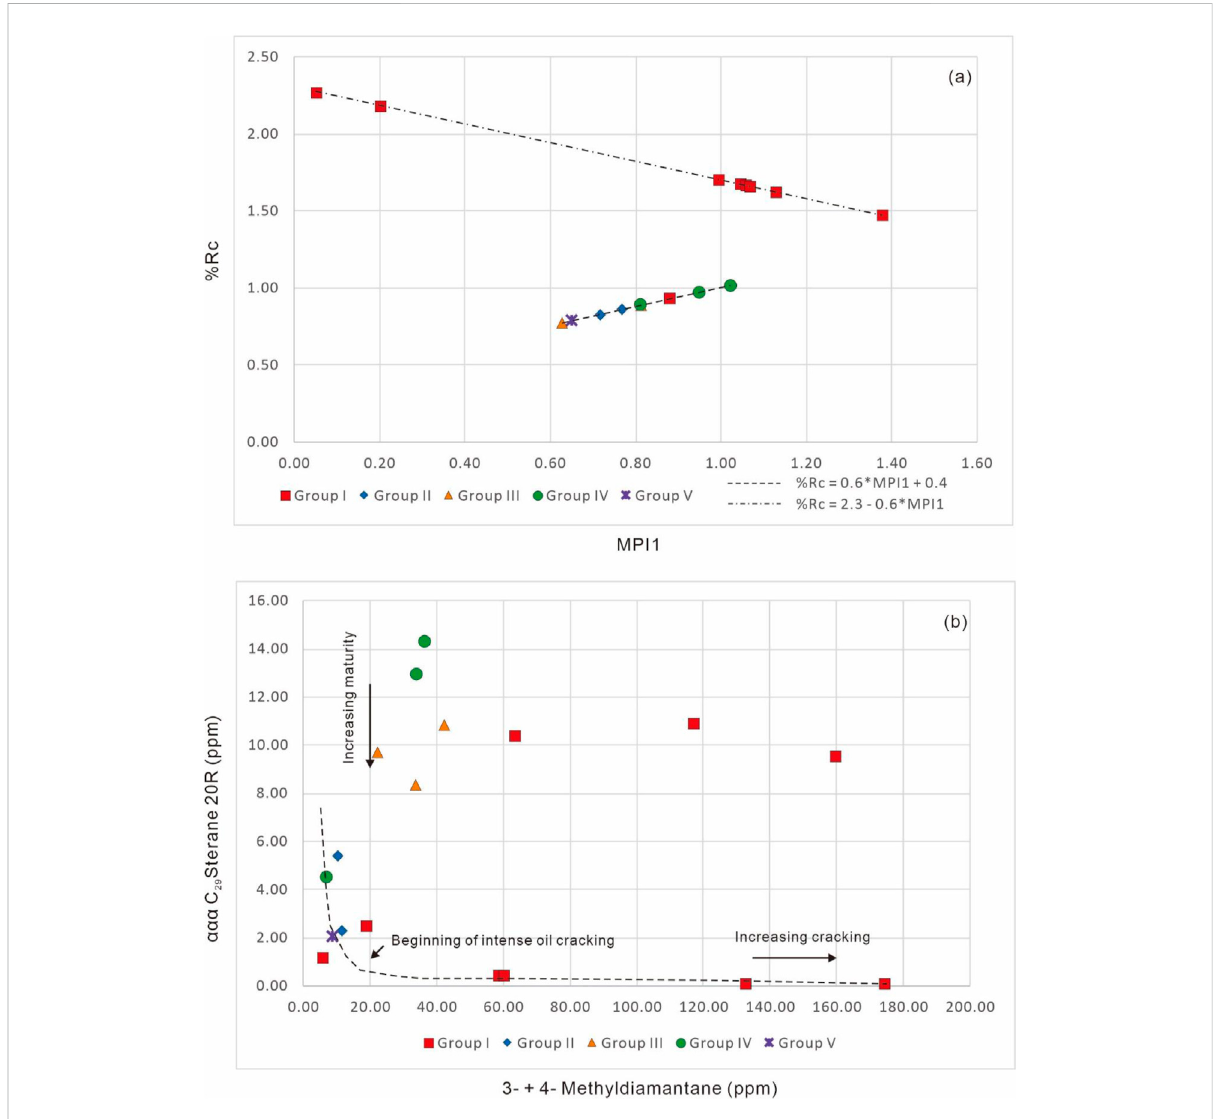
FIGURE 7 Crossplot of (A) MPI1 versus %Rc; (B) concentrations of 3- + 4-methyldiamantane versus those of ααα C 29 sterane